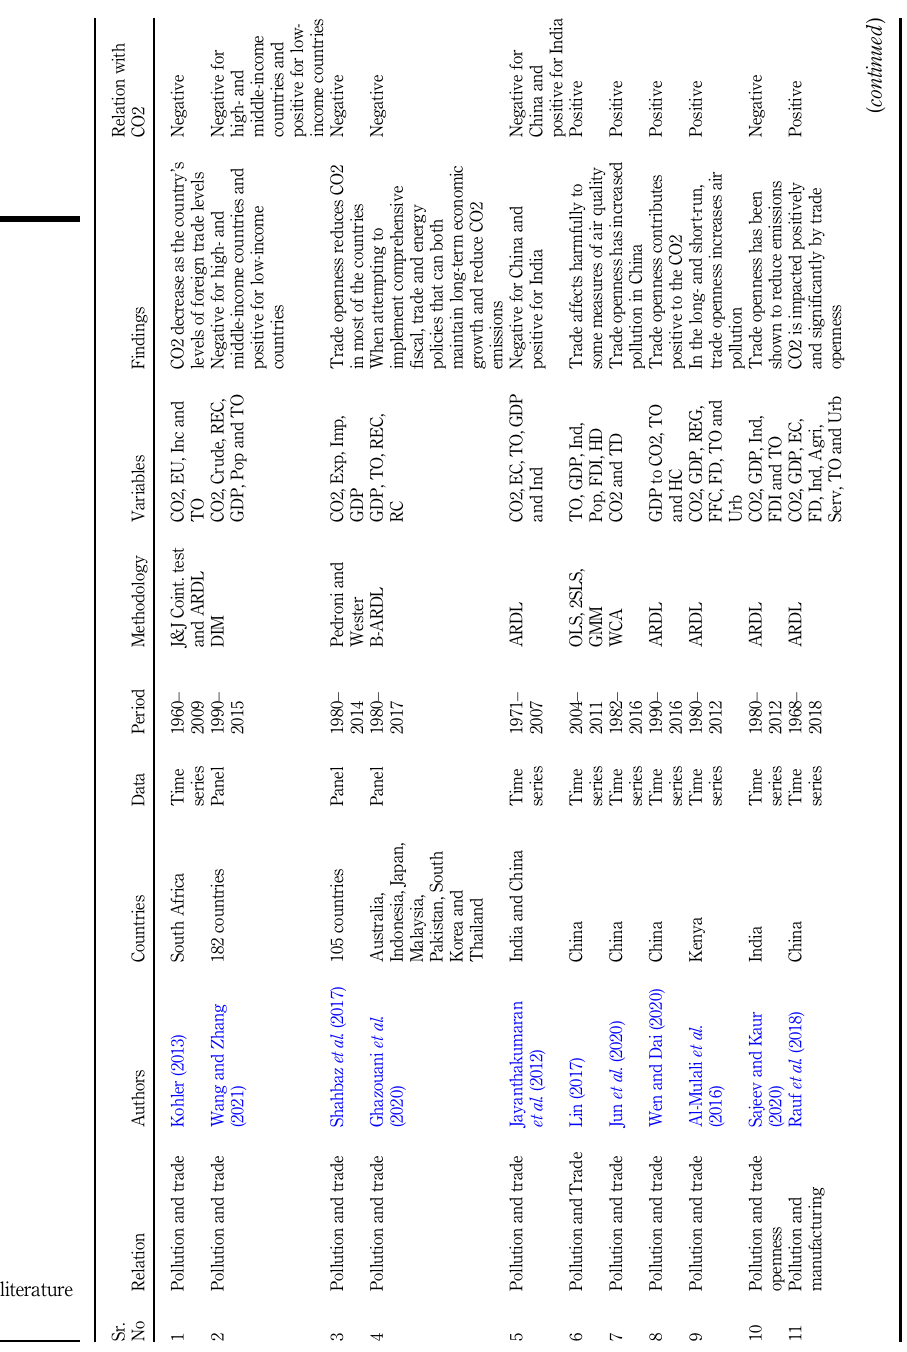
Table 1. Summary of literature